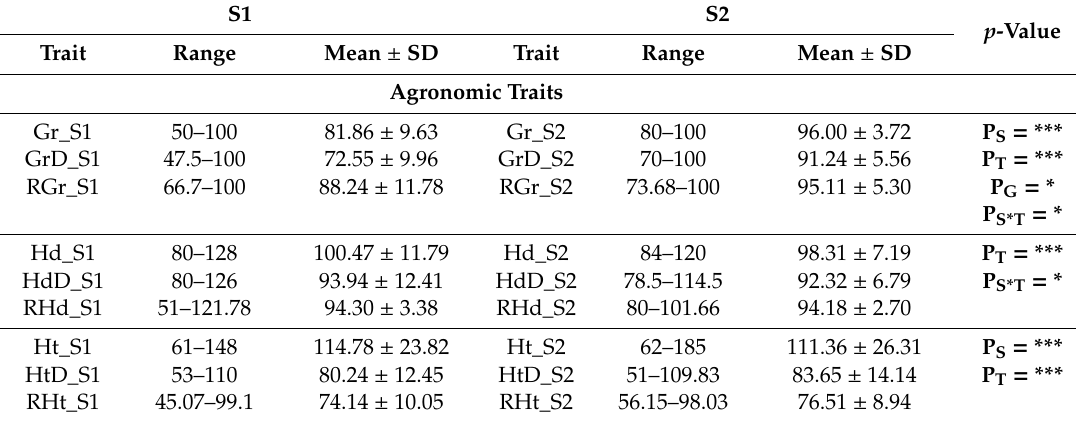
Table 1. Range and mean ± SD of traits measured in S1 and S2 including significant di ff erences among genotypes, seasons, treatments, genotype x season, genotype x treatment, season x treatment